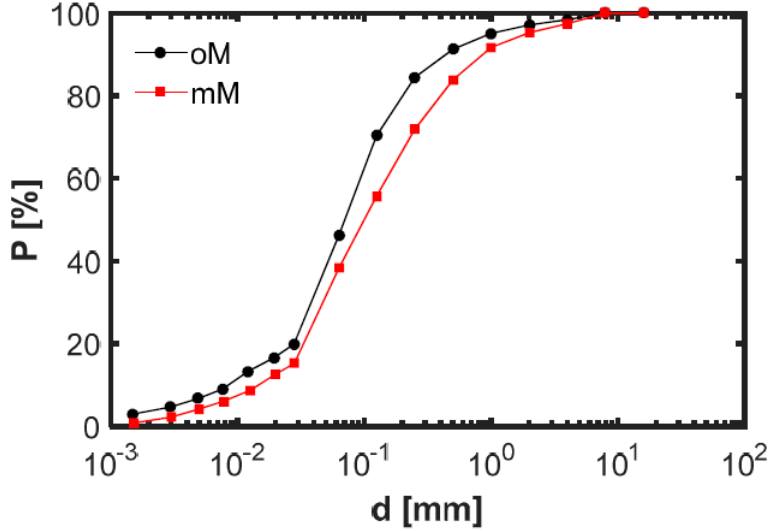
Figure 3. Grain size distributions (percent passing P vs. grain diameter d plots) of the two till soils. For the XRD plots of Figure 4, only the dominant (minerals with a significant compar- ative fraction of the total soil grain mass or volume) are noted, and hence other mineral forms existing in the soil structure at low or negligible fractions have not been included. On this basis, the particle grain skeletons of both oM and mM tills heavily comprised quartz and calcite minerals, with till mM also having an additional significant presence of albite (a member of the plagioclase feldspar group)